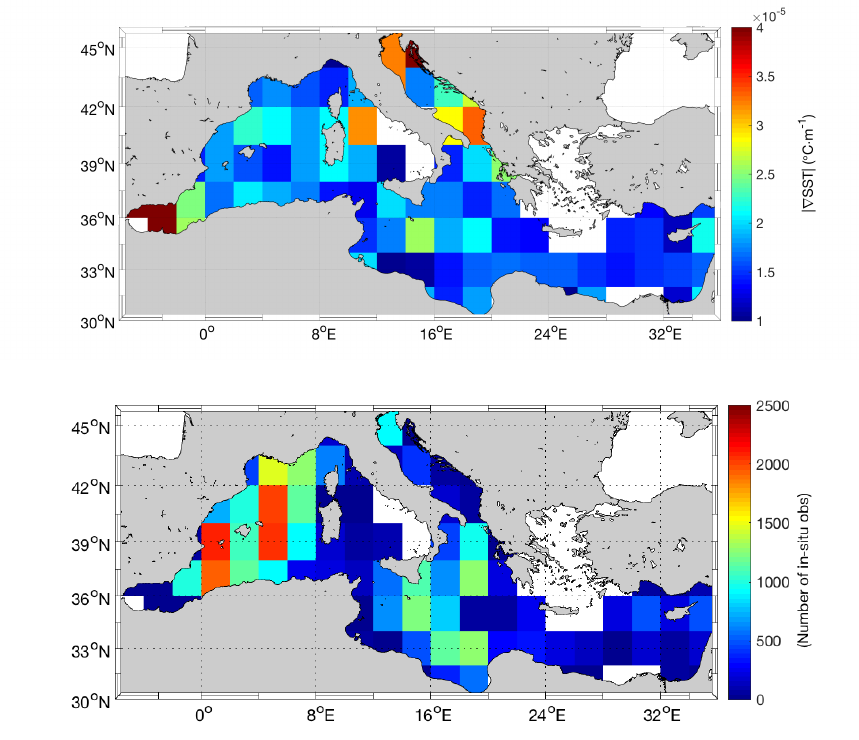
Figure 11. Top panel: | ∇ SST| binned in 1 ◦ × 1 ◦ boxes, computed along the positions occupied by the drifting buoys during the period 2012–2016. Bottom panel: Number of in-situ surface-currents observations laying in each of the 1 ◦ × 1 ◦